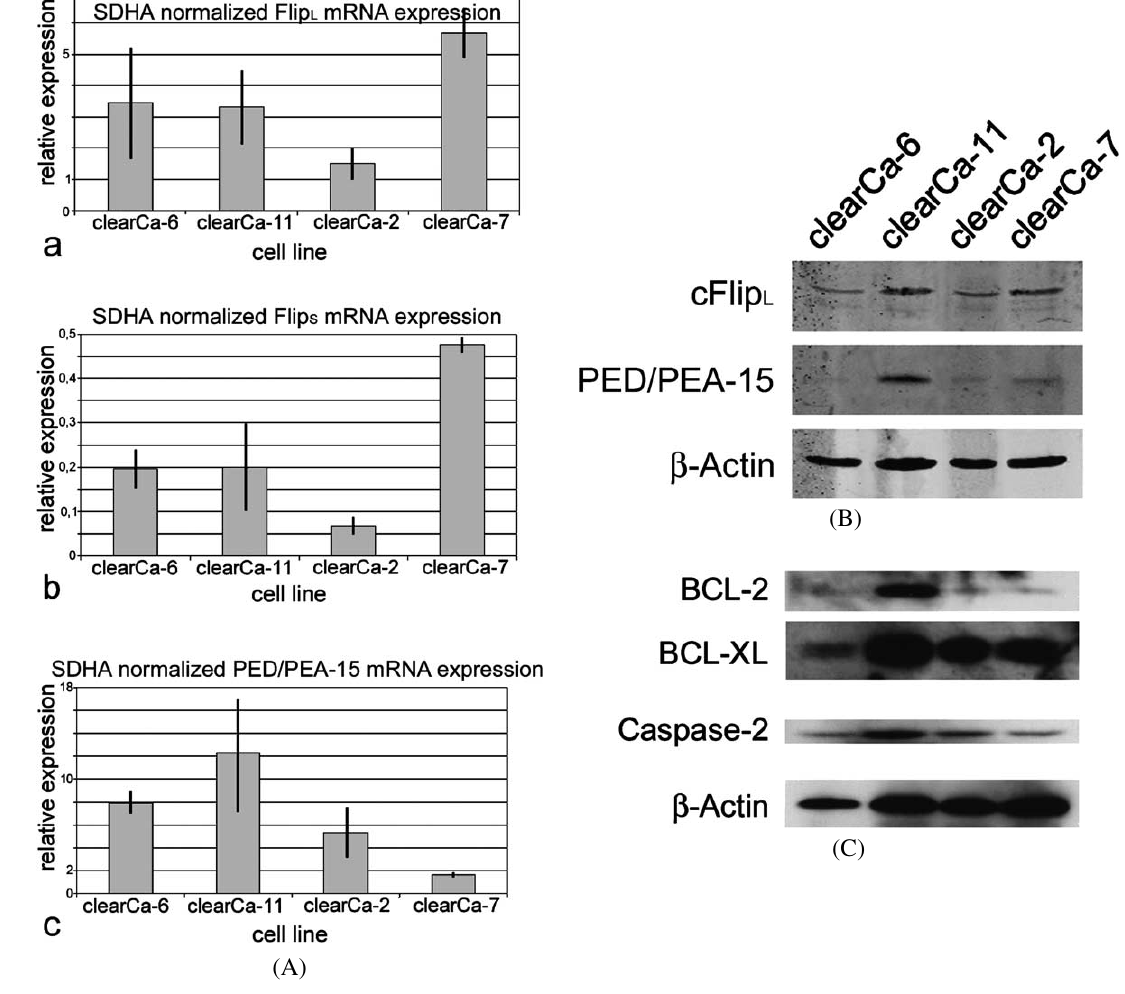
Fig. 3. Real time PCR analysis of caspase-8 inhibiting genes and Western Blot analysis of pro- and anti-apoptotic proteins in RCC cell lines. (A): Expression of the caspase-8 inhibiting genes cFlip L (a), cFlip s (b) and PED/PEA-15 (c) in RCC cell lines does not correlate with suscepti- bility towards TRAIL-induced apoptosis (shown is the median ± standard deviation of two independent experiments). (B): Expression of the cas- pase-8 inhibiting proteins cFlip L and PED/PEA-15 could be detected in all RCC cell lines whereas cFlip S protein expression could not be shown by Western Blot. Protein expression levels slightly differed from the relative mRNA expression levels comparing the RCC cell lines. However, no correlation between the protein expression level of cFlip L and PED/PEA-15 and apoptosis-susceptibility could be observed. (C): Expression of BCL-XL and BCL-2, inhibitors of the mitochondrial pathway of apoptosis, in all RCC cell lines with lowest expression in clearCa-6. Detection of caspase-2, which is responsible for transduction of DNA damage signals to the mitochondria in all RCC cell